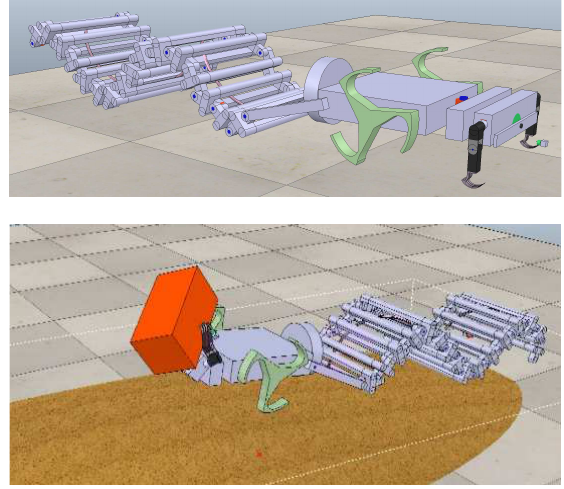
Figure 3. A pair of three-degree of freedom (DoF) manipulators has been included as a frontal module for the robot acting as legs to improve climbing capabilities and as arms to manipulate